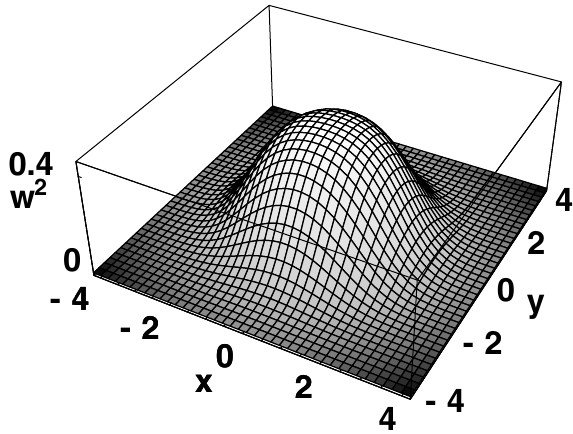
FIG. 3. Three-dimensional view of the transverse distribution p (cid:1)(cid:1)(cid:1)(cid:1)(cid:1)(cid:1)(cid:1)(cid:1)(cid:1)(cid:1)(cid:1)(cid:1)(cid:1)(cid:1)(cid:1)(cid:1) (cid:3) for a space-charge strength of (cid:7) (cid:21) 11 : 2 . x 2 (cid:5) y 2 w 2 (cid:2)